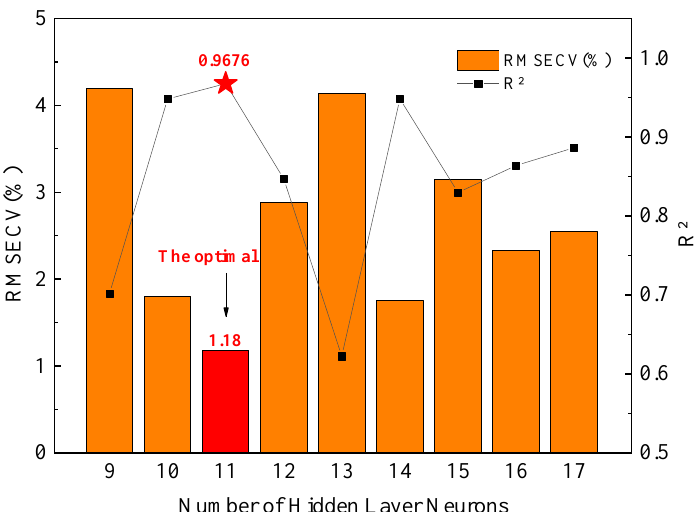
Figure 6. The RMSECV and R 2 values of ANN with different numbers of hidden layer neurons.